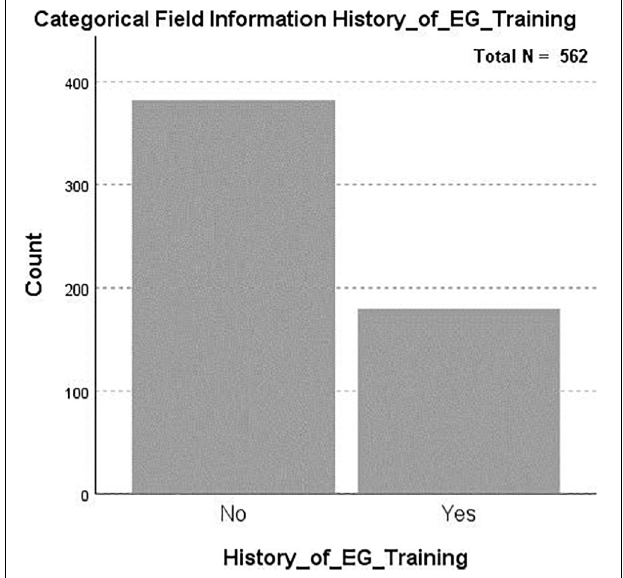
FIGURE 3 | Percentage of QU-Health students who attended and did not attend EG